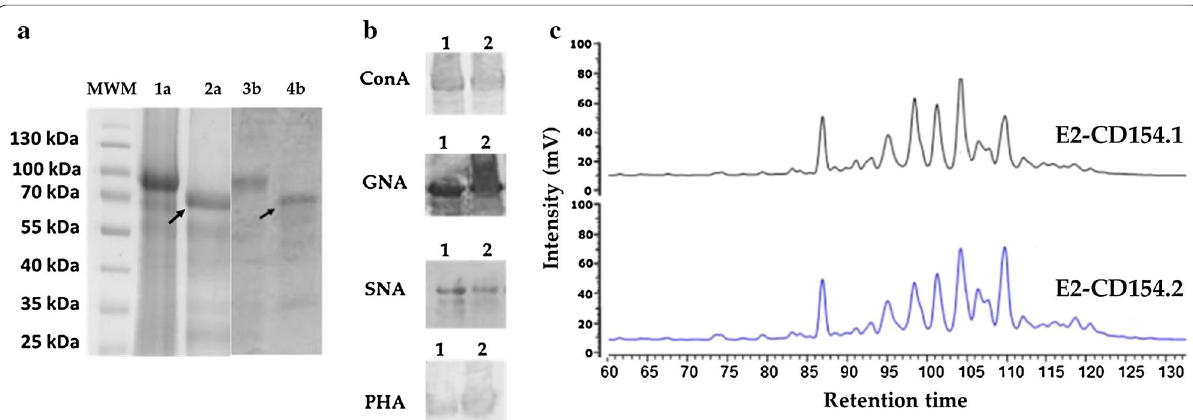
Fig. 4 Characterization of the N ‑glycans linked to the E2‑CD154 proteins. a 10% SDS‑PAGE under reducing conditions. MWM: Molecular weight marker; 1a and 1b: E2‑CD154.1 and E2‑CD154.2 proteins expressed by HEK293 cells in fermenter respectively; 2a and 2b: E2‑CD154.1 and E2‑CD154.2 after PNGase F treatment, respectively. The arrows indicate the putative non‑glycosylated proteins. b Results of lectin specific assays to detect the quality of N ‑glycans bound to both E2‑CD154 proteins, 1: E2‑CD154.1; 2: E2‑CD154.2. c NP‑HPLC chromatograms of 2AB derivatives from E2‑CD154N‑glycan